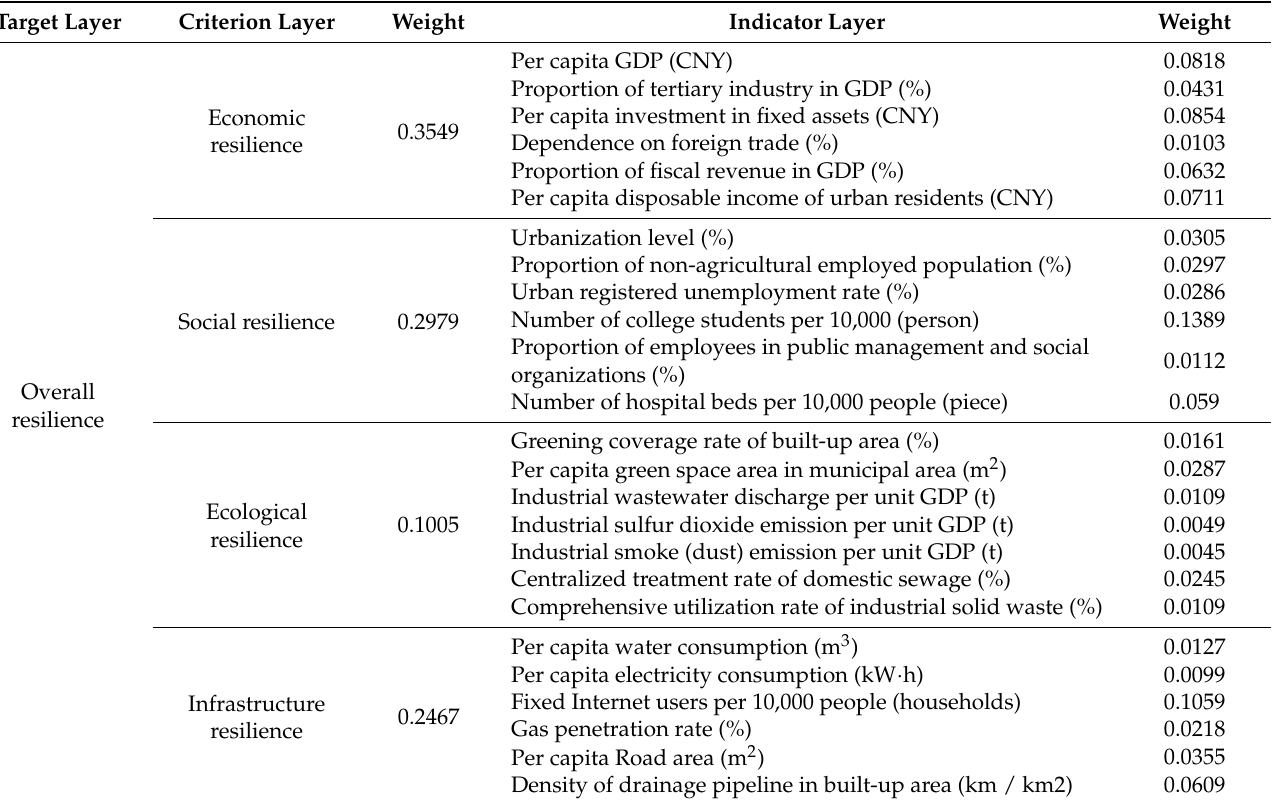
Table 2. Weights of Evaluation